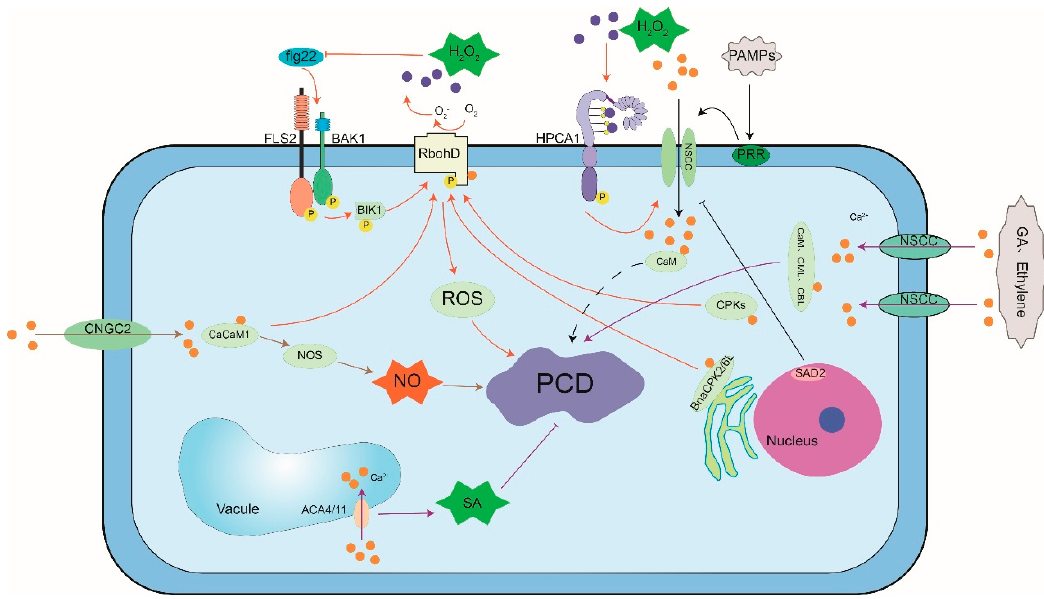
Figure 4. Crosstalk between calcium signal and ROS-, NO-, phytohormone-induced PCD. HPCA1: hydrogen peroxide sensor; PAMPs: pathogen associated molecular pattern; PRR: pattern recognition receptor; RBOHD: respiratory burst oxidase homolog protein; SA: salicylic acid; GA: gibberellin. (based on [145–161]).